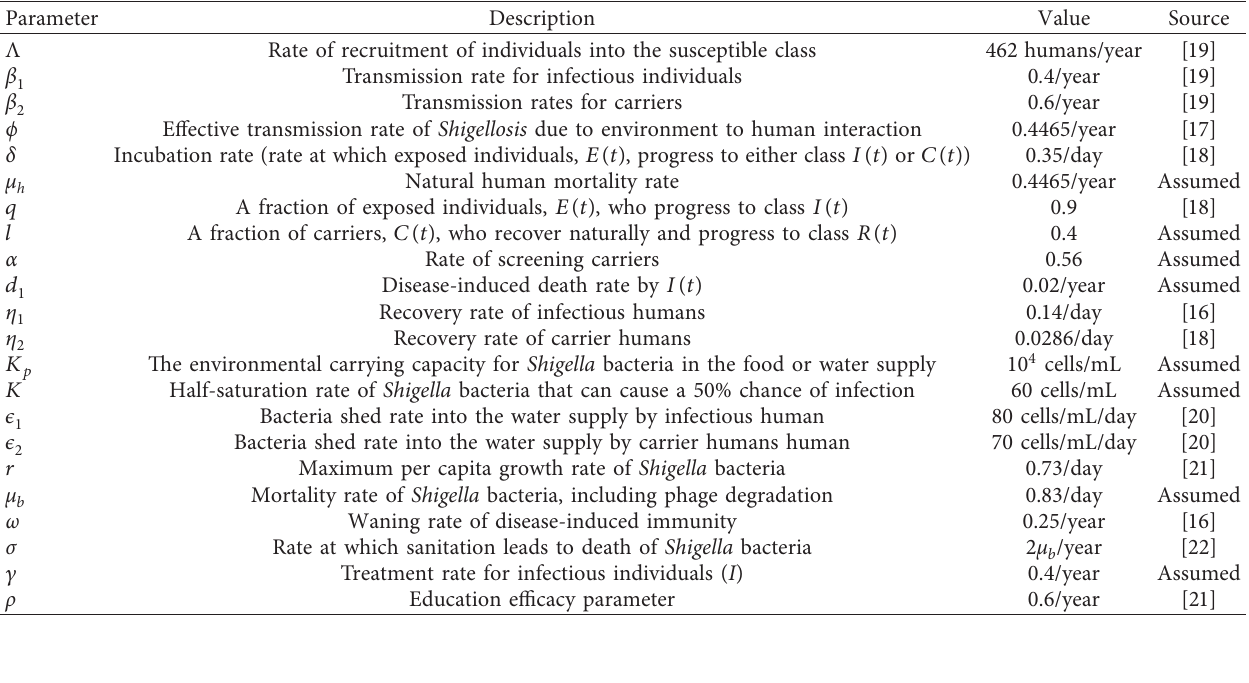
Table 2: Parameters and their description.